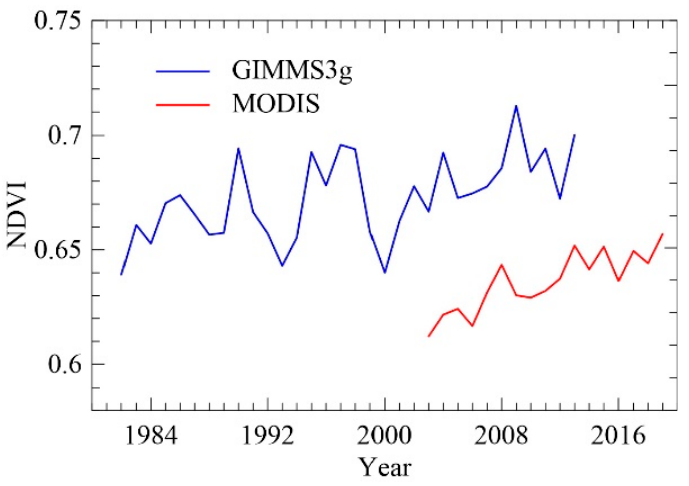
Figure 2. Temporal variations of growing season (May–September) NDVI during 1982 to 2019 in the YREB.